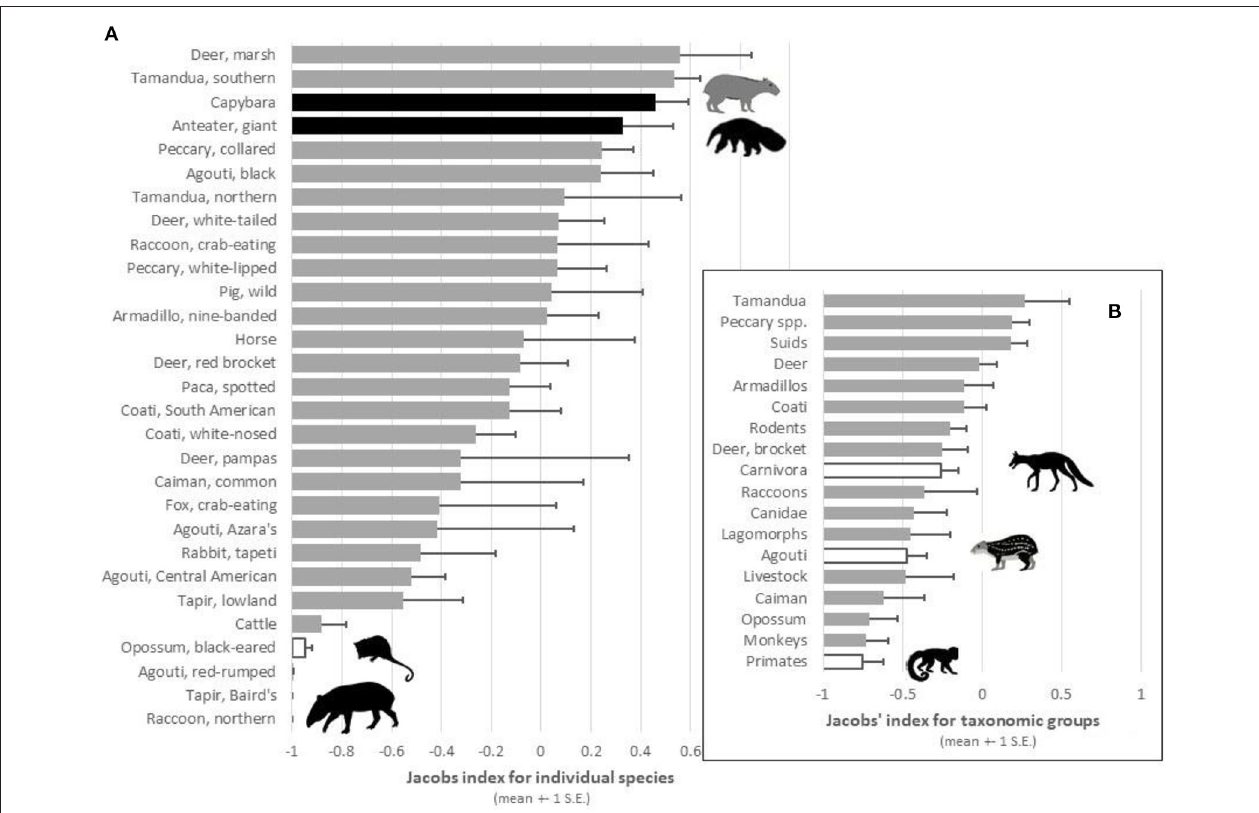
FIGURE 2 | Plot of the mean Jacobs’ index values ( ± 1 S.E.) of preference for (A) prey species and (B) taxonomic groups that were reported as potential prey of jaguars in at least two study sites. Black bars represent significantly preferred species, white bars significantly avoided species, and gray bars species killed in accordance with their